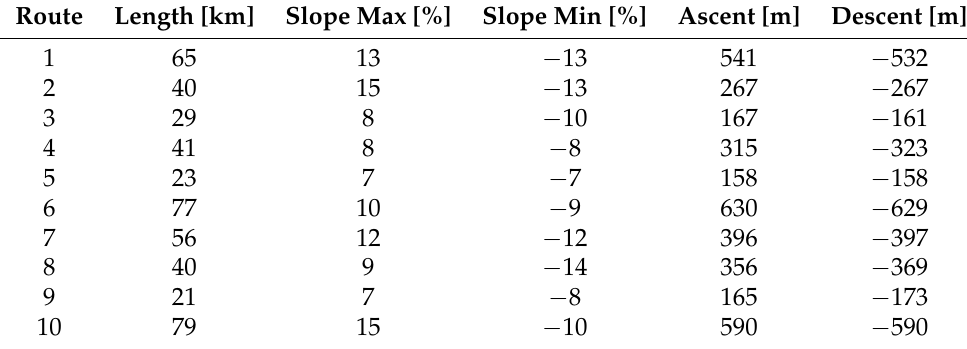
Table 4. Route profile parameters of the map–based driving